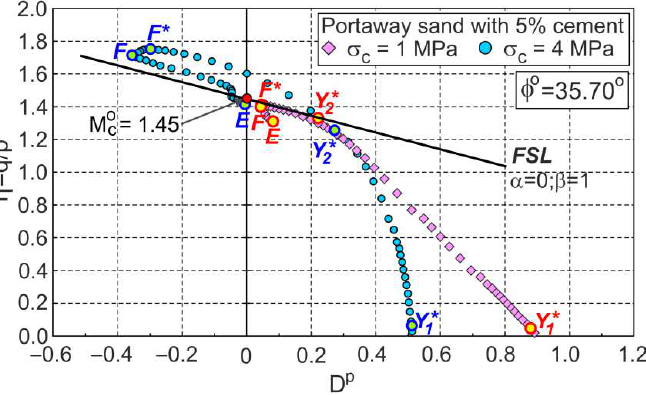
Figure 2. The stress ratio–plastic dilatancy relationship for the drained triaxial compression of Portaway sand with 5%